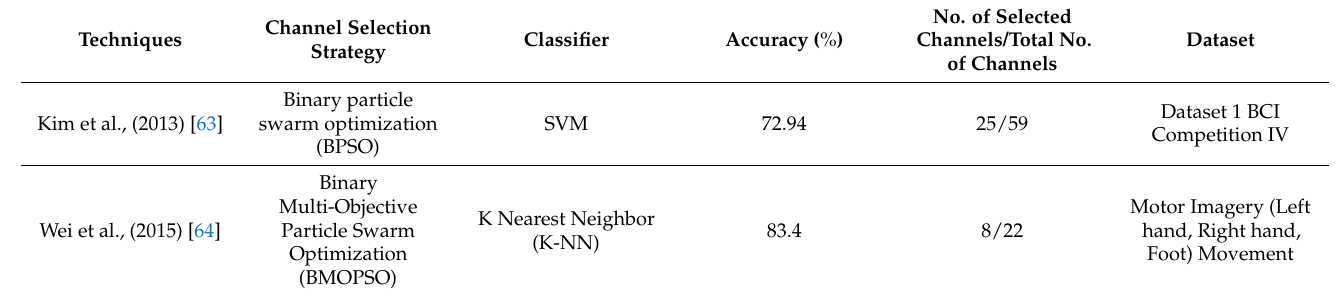
Table 5. Particle swarm optimization-based techniques for motor imagery EEG channel